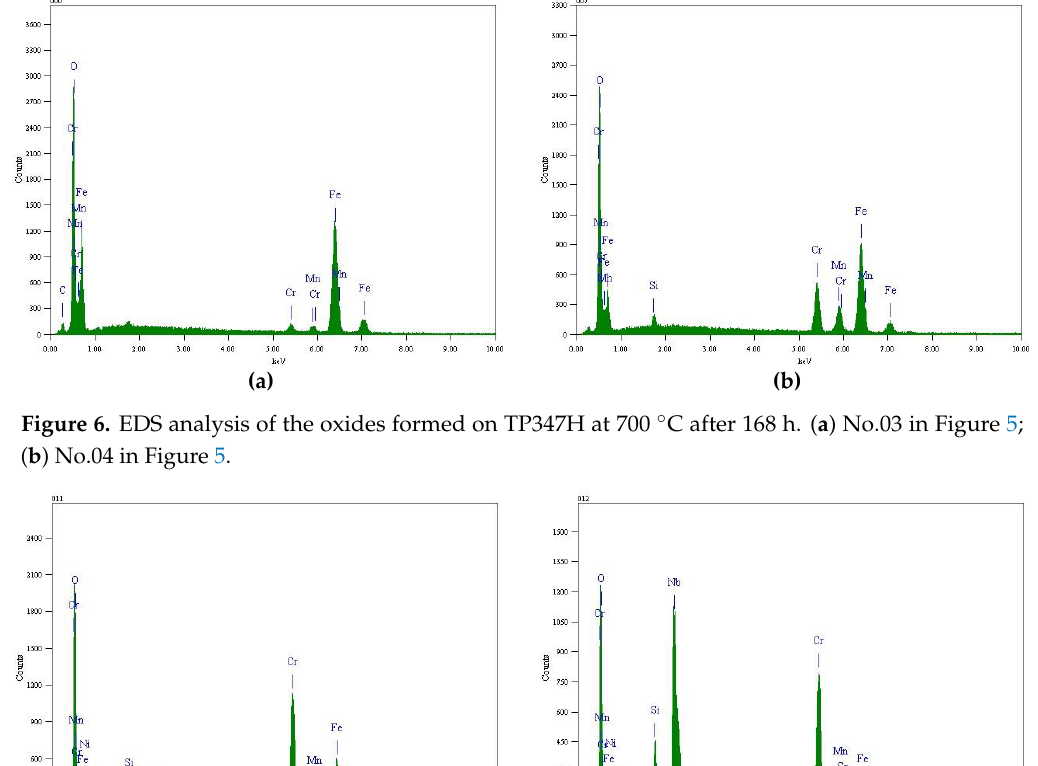
Figure 5. Surface morphology of TP347H and TP347HFG at 700 °C after 168 h. ( a ) TP347HFG; ( b ) TP347HFG; ( c ) TP347HFG; ( d ) TP347H; ( e ) TP347H; ( f ) TP347H.